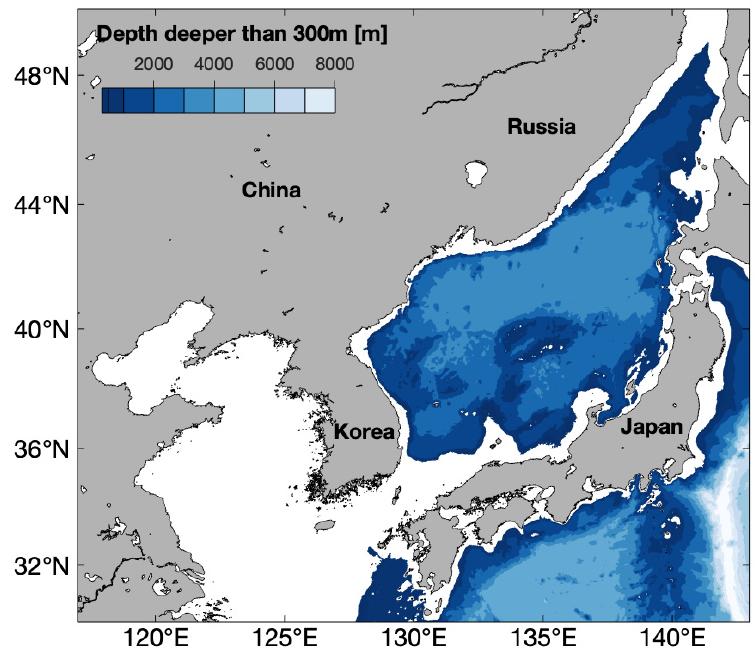
Figure 5. Colored map of areas where water depth is greater than 300 m in the eastern sear of Korea and Japan.